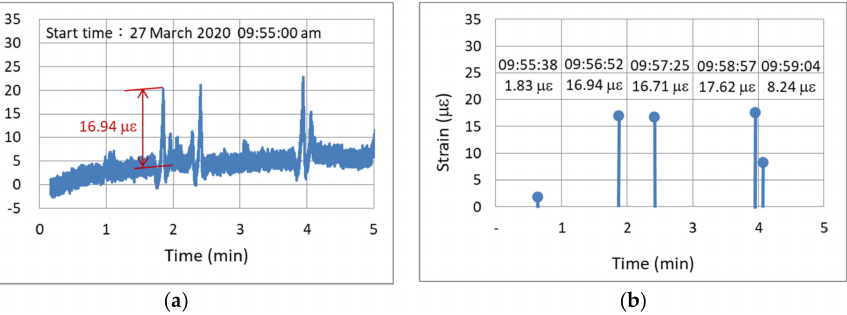
Figure 14. Results of dynamic strain verification: ( a ) output of continuous waveforms; ( b ) output of edge computing.